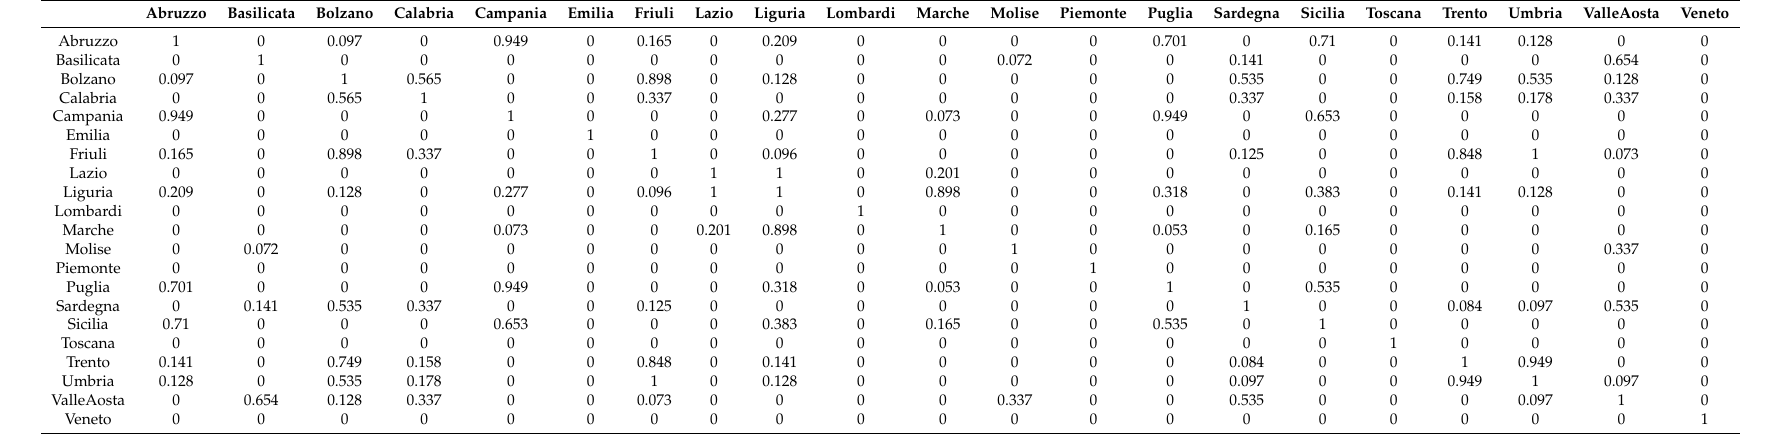
Table A36. Similarity values of New Currently Positive network in the fifth